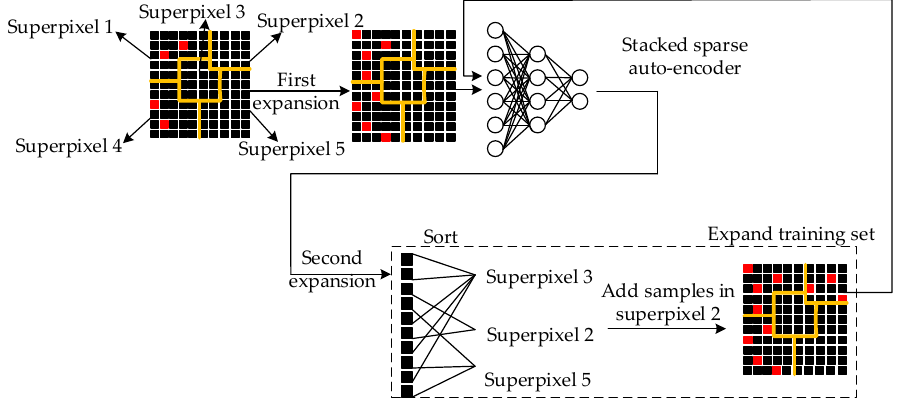
Figure 1. The flow of semi-supervised unlabeled sample selection. Take five superpixels in a neighborhood for example. Red squares indicate labeled training samples and black squares indicate unlabeled candidate samples, respectively.